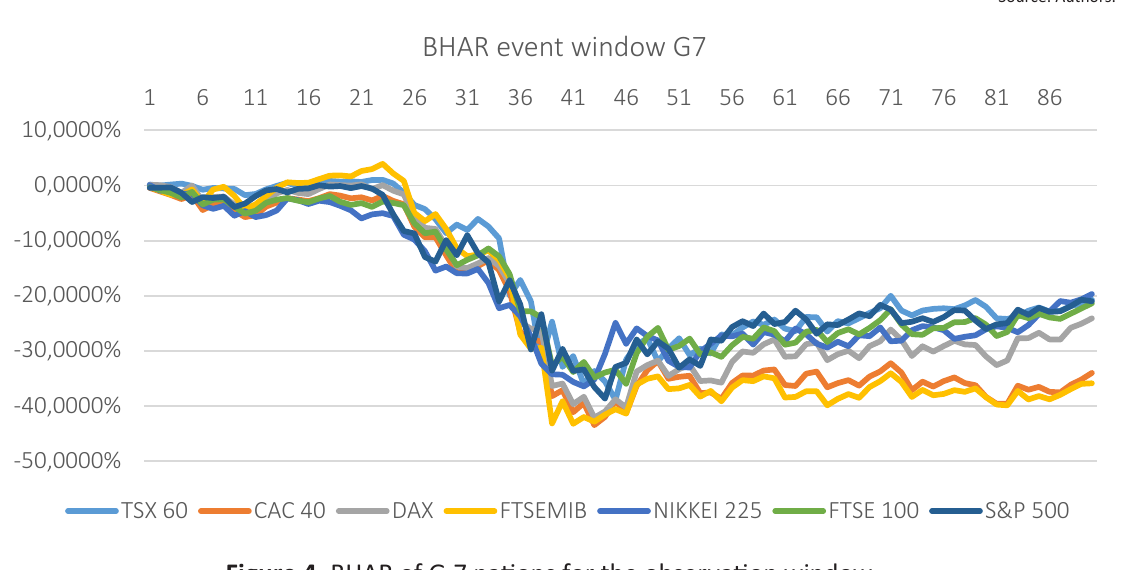
Figure 4. BHAR of G-7 nations for the observation window